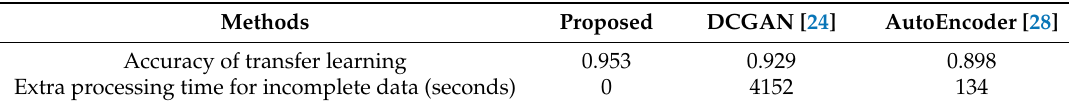
Table 2. Performances comparison of the three methods.